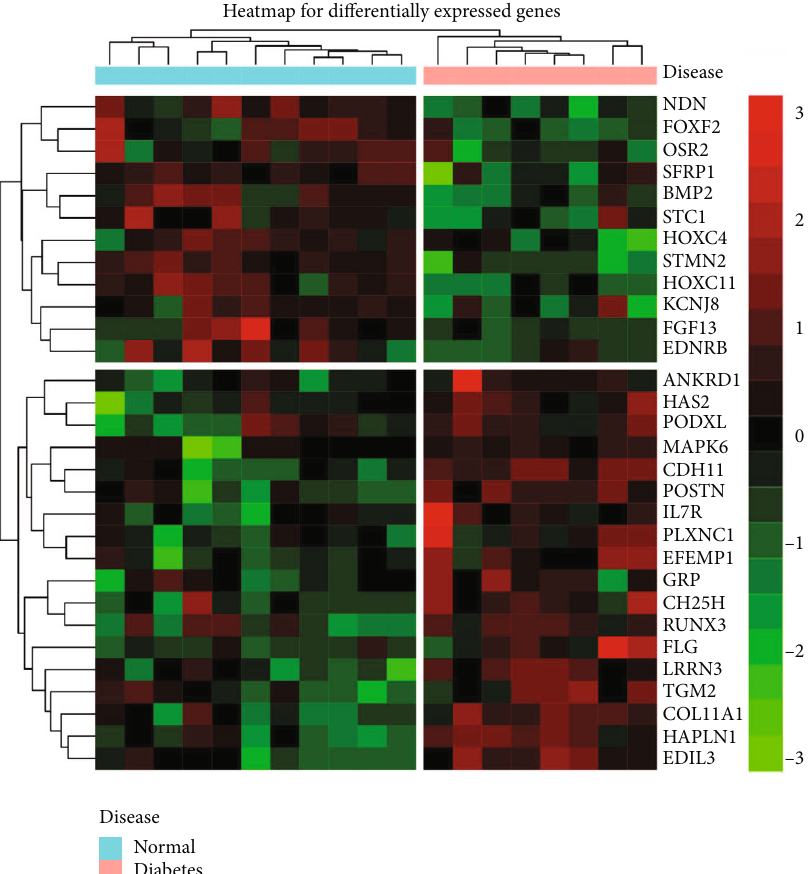
Figure 1: The heatmap of di ff erentially expressed mRNAs in human dermal fi broblasts from the diabetic and normal skins. The samples used for mRNA expression pro fi ling analysis were derived from 11 diabetic skins and 9 normal skins. A total of 30 mRNAs were signi fi cantly deregulated, with 12 mRNAs downregulated and 18 mRNAs upregulated. Red signals and green signals represent upregulated expression and downregulated expression,